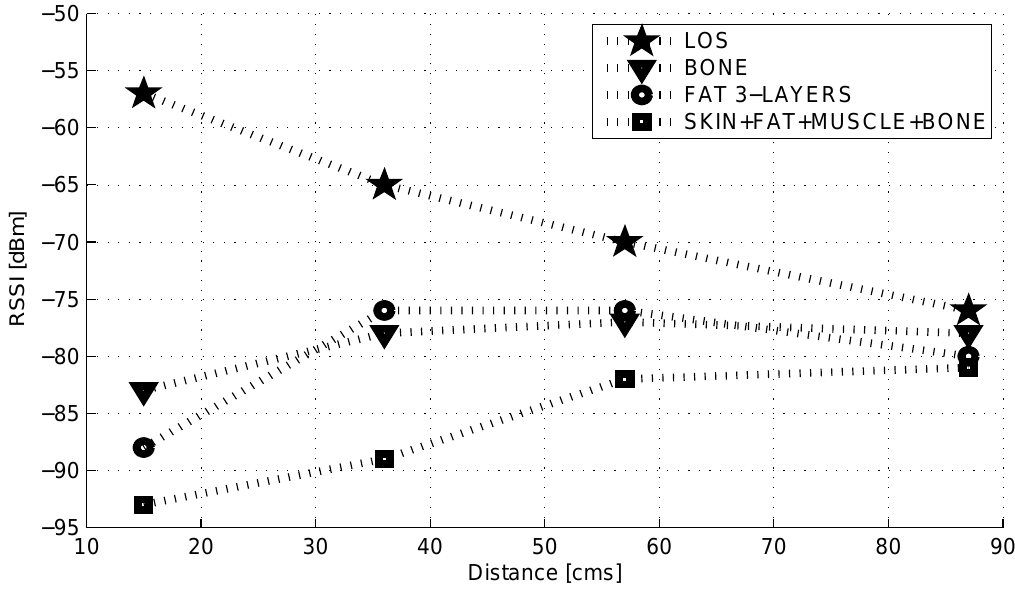
Figure 2. RSSI vs . Distance for LOS/NLOS links in anechoic